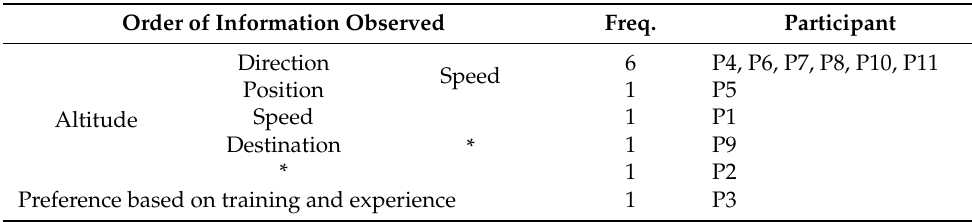
Table 9. Order of information observed for converging aircraft.